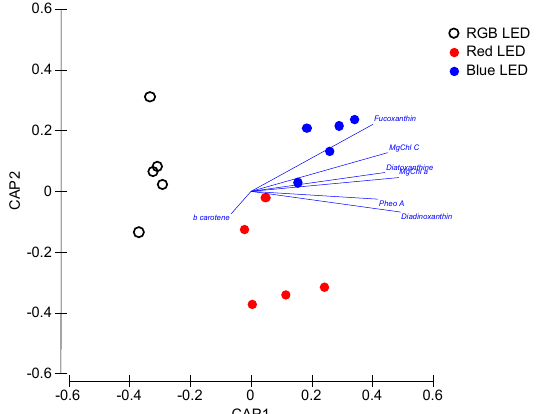
Figure 6. Canonical Analysis of Principal (CAP) components of the P. tricornutum cultures ( N = 5) subjected to the three light treatments, having as basis the full pigment profile at the end of the 96 h exposure period (93.3% classification efficiency).